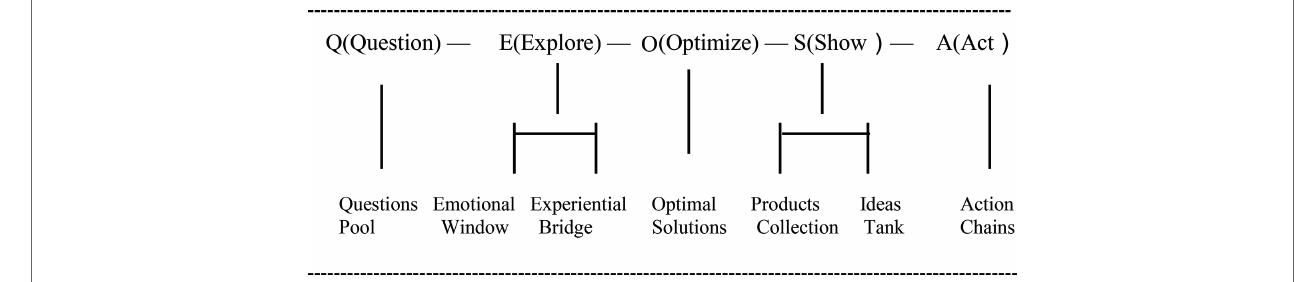
FIGURE 1 | QEOSA: A pedagogy model specifying five phases and seven